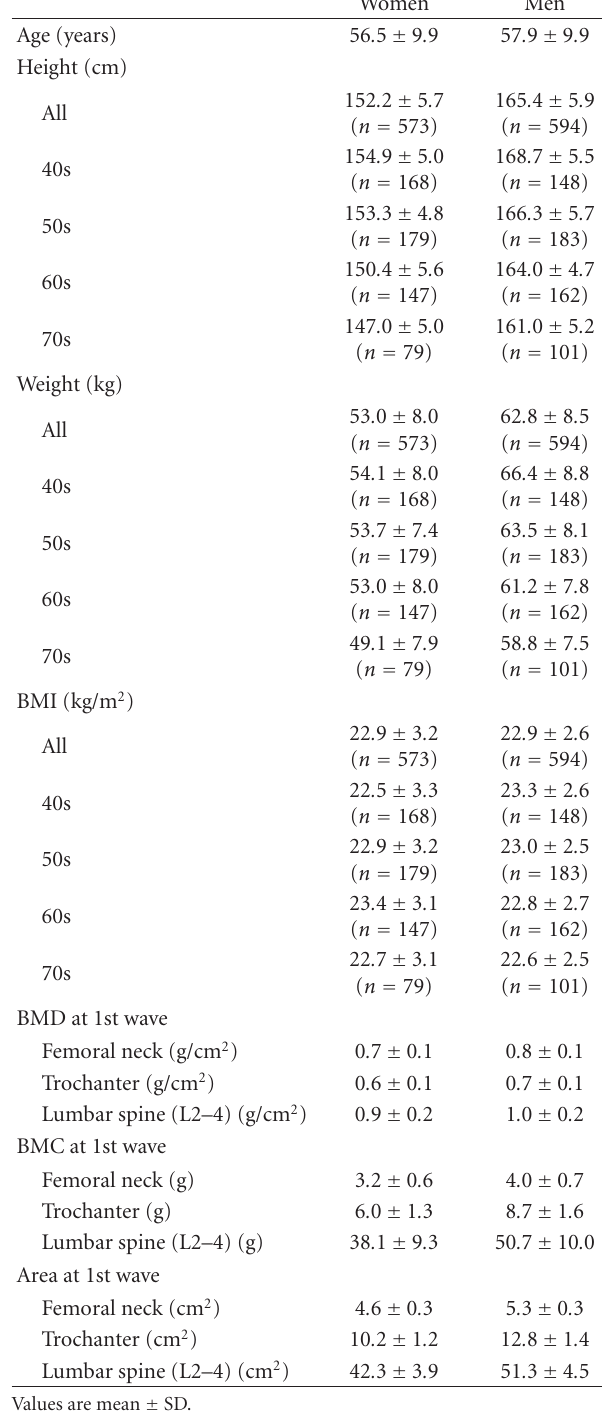
Table 1: Characteristics of